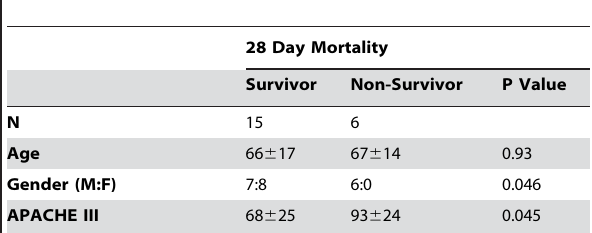
Table 1. Patient demographics and clinical